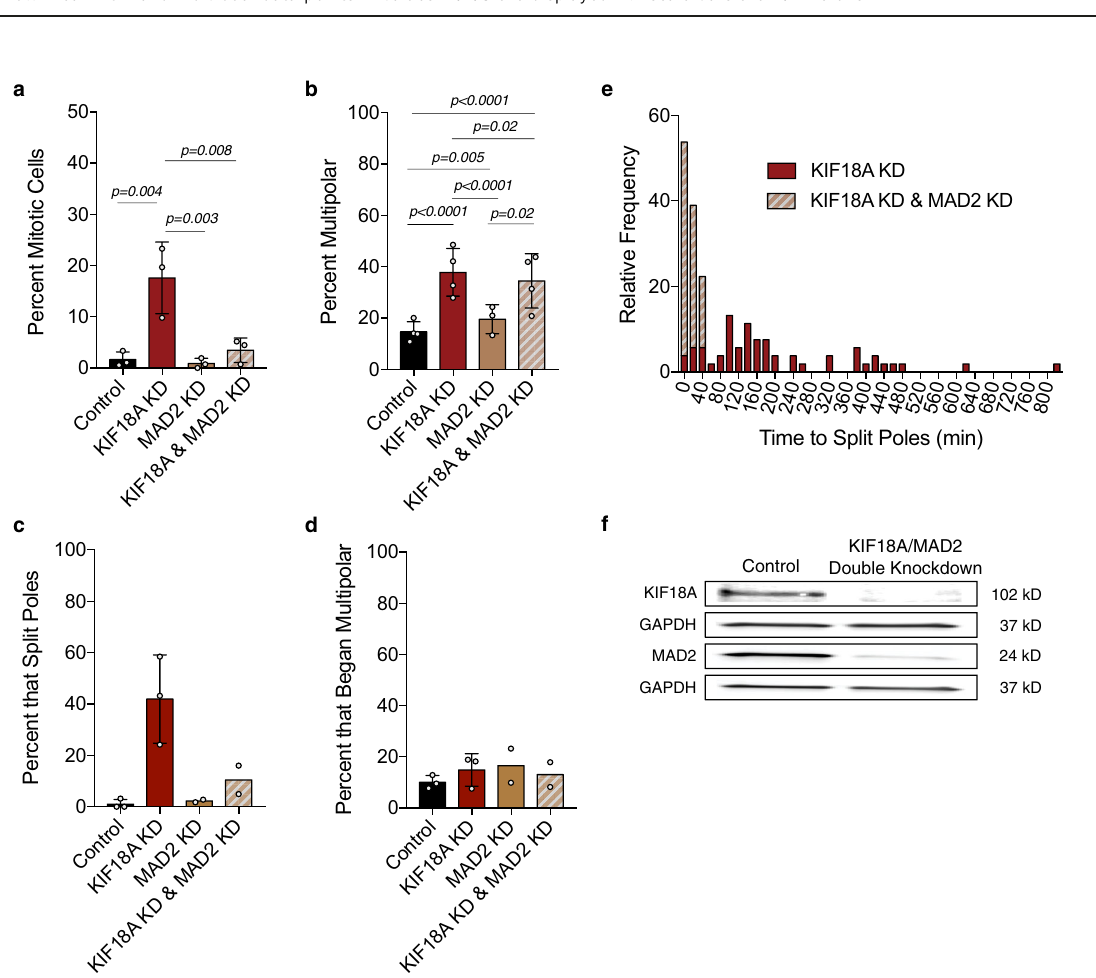
Fig. 4 Loss of KIF18A causes centrosome fragmentation in MDA-MB-231 cells. a Representative images from fi ve independent experiments of MDA- MB-231 cells treated with either control (top) or KIF18A (bottom) siRNAs. Pericentriolar material ( γ -tubulin, red) is numbered to show poles with and without centrioles (centrin-1, green). Microtubules ( α -tubulin) are labeled in white. b Percent of mitotic cells from each indicated cell line with multipolar spindles following treatment with either control or KIF18A siRNA. n = 9 (control KD) and 5 (KIF18A KD) independent experimental replicates for MDA- MB-231. n = 3 (HT29, HCC1806, SW480), 4 (HeLa), and 5 (MCF10A) independent experimental replicates. Data were analyzed via unpaired, two-tailed t test. c Plot of multipolar spindle percentage as a function of fold change (FC) in cell number for the indicated cell lines following KIF18A KD. R-squared value is 0.79 using a linear regression model. d Representative images from three independent experiments of an MDA-MB-231 cell with a third pole ( γ - tubulin, magenta) lacking centrin-1 (green). e Percent of multipolar MDA-MB-231 cells in mitosis with fragmented pericentriolar material (PCM), as indicated by the presence of γ -tubulin puncta lacking centrin-1 puncta. n = 18 (control KD) and 58 (KIF18A KD) multipolar cells from three independent experiments. Data were analyzed via a two-sided Chi-square test. f Intercentriolar distance measurements (in microns) for MDA-MB-231 cells in each indicated category. n = 81 (control KD bipolar), 38 (control KD multipolar), 94 (KIF18A KD bipolar), and 91 (KIF18A KD multipolar) centriole pairs from three independent experiments. Data were analyzed via one-way ANOVA with post hoc Tukey ’ s test for multiple comparisons. g Representative still